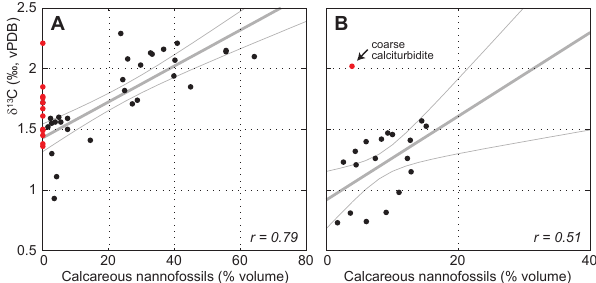
Fig. 8. Carbon isotope composition ( δ 13 C) of lime mudstone plot- ted against the abundance of calcareous nannofossils at Pizzo Mon- dello (A) and Pignola-Abriola (B) . The δ 13 C is clearly correlated with nannofossil abundance (see correlation coefficients ( r )) which are both significantly different from zero at the 95% level. Lin- ear fit is plotted with 90% error bounds. Twelve samples of Pizzo Mondello without nannofossils and one sample of Pignola from a 2m thick coarse calciturbidite are marked in red and were excluded from